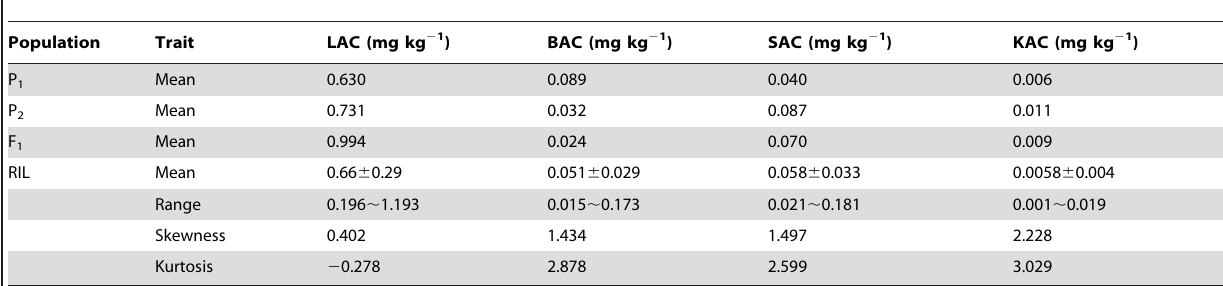
Table 1. Performance of As concentration in the four tissues of maize in the RIL population.